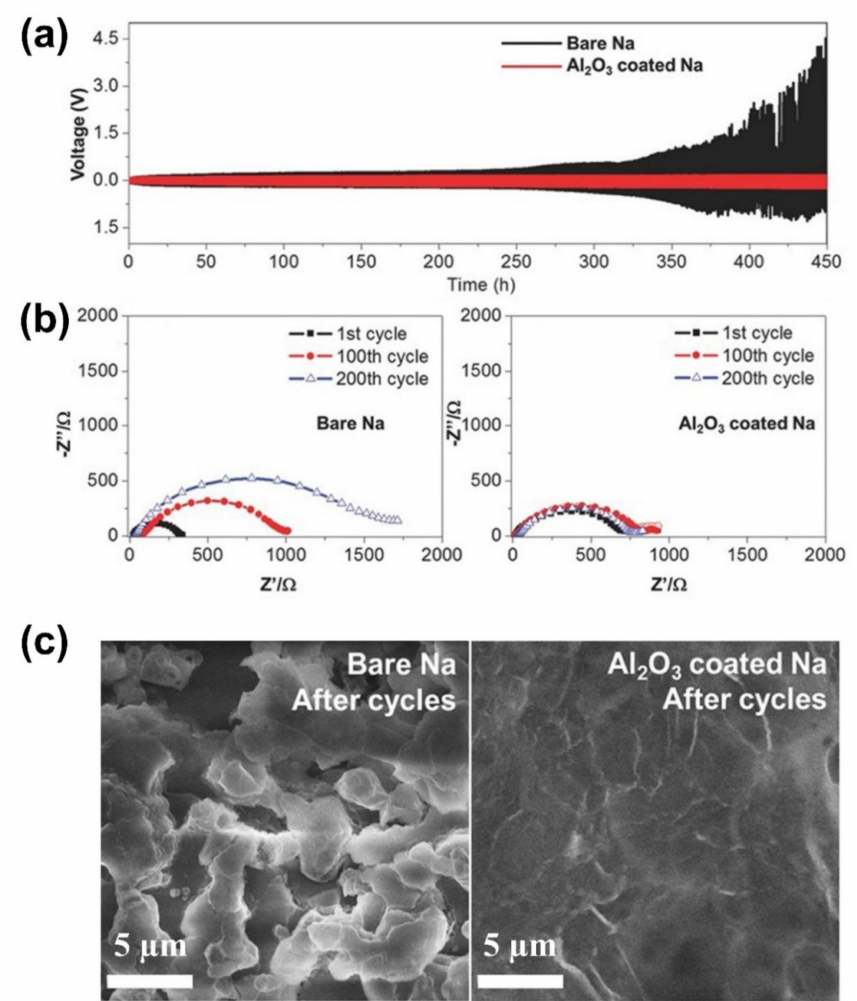
Figure 5. ( a ) Symmetric cell cycling performance for bare Na and Al 2 O 3 -coated Na (0.25 mA cm − 2 ), ( b ) EIS analysis of symmetric cells at the 1st, 100th, and 200th cycle, and ( c ) Post-cycling top-view SEM images of the bare Na and the Al 2 O 3 coated Na metal electrodes [94]. Reproduced with permission [94]. Copyright 2016,